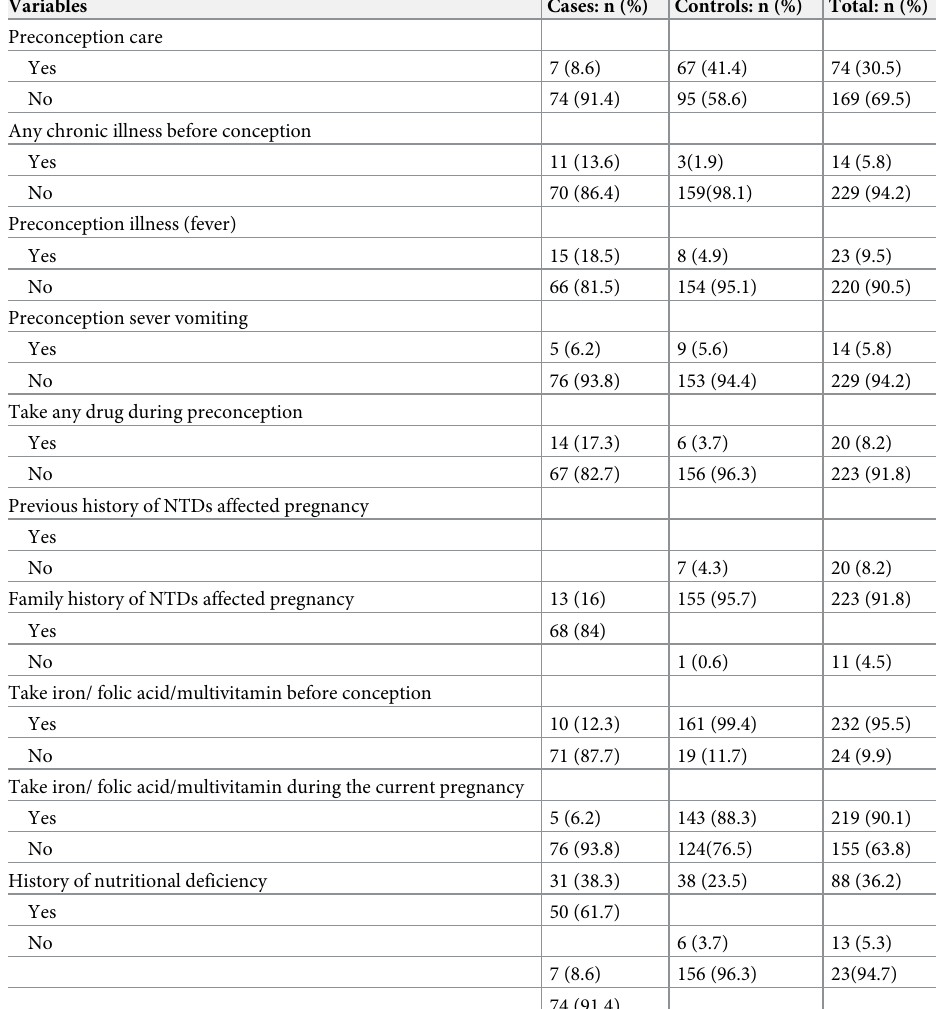
Table 3. Medical history of mothers who gave birth in North Shoa Zone Hospitals, Amhara Region, Ethiopia,